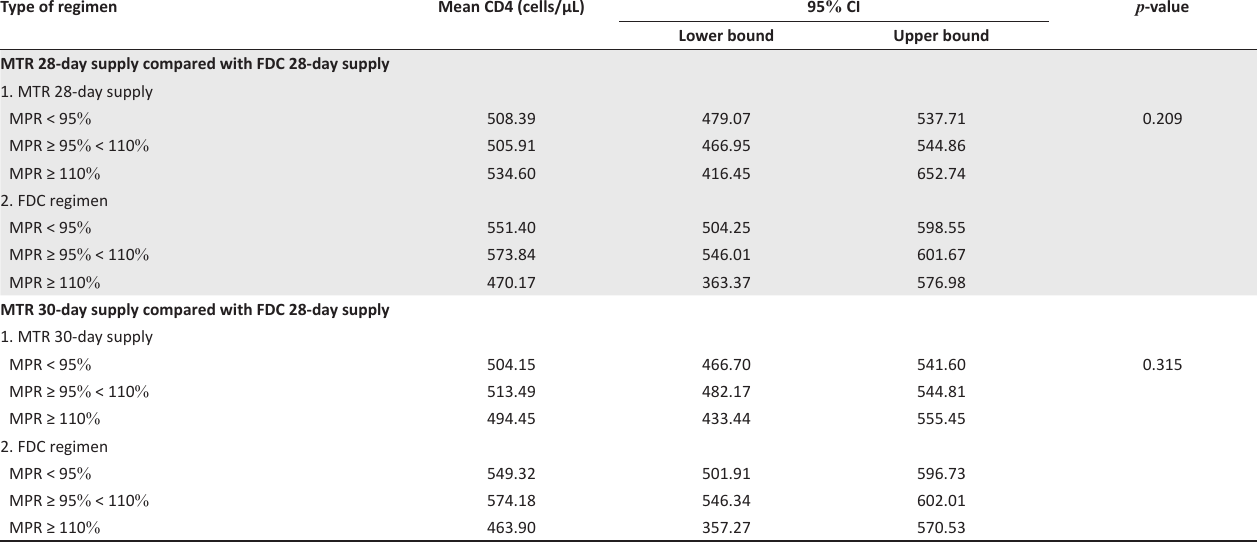
TABLE 4: The effect of regimen type and adherence categories on CD4 count. Type of